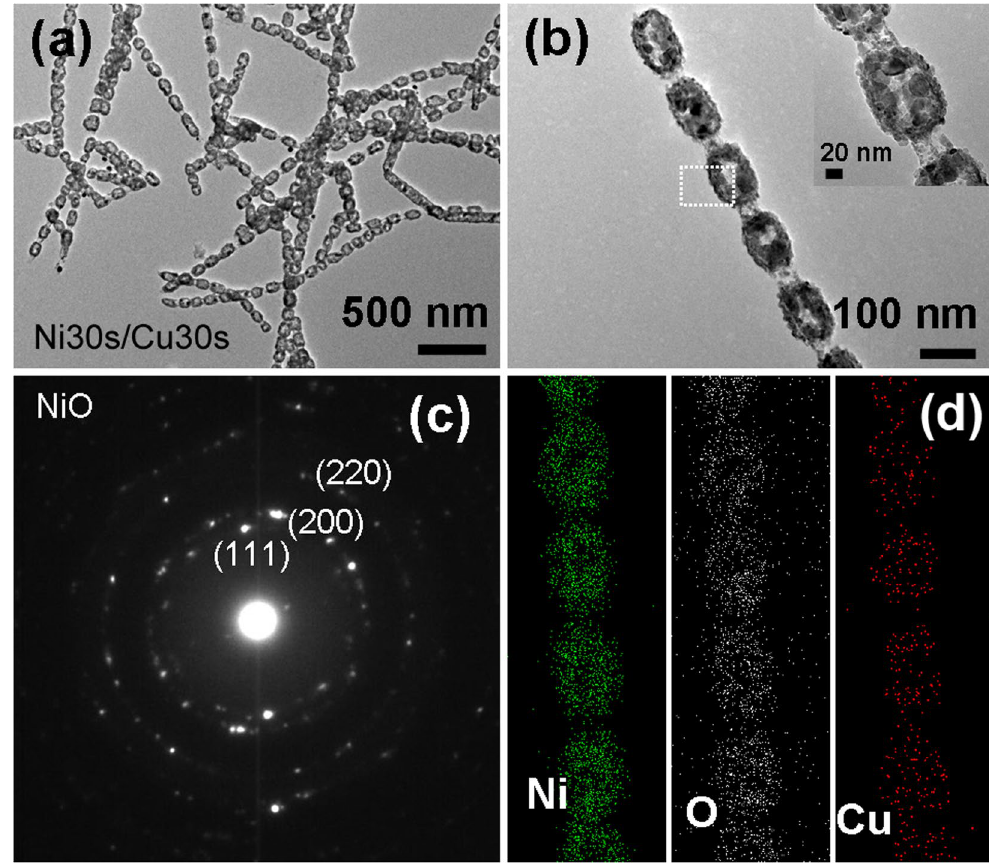
Figure 5. Characterization results of Ni30s/Cu30s sample. ( a ) TEM image of sample after annealing at 700 °C for 2 h in air; ( b ) a single chain after annealing and the inset is the magnified TEM image; ( c ) SAED pattern for the hollow particle area labeled in ( b ); ( d ) EDS element mapping image of the single hollow particle chain in ( b